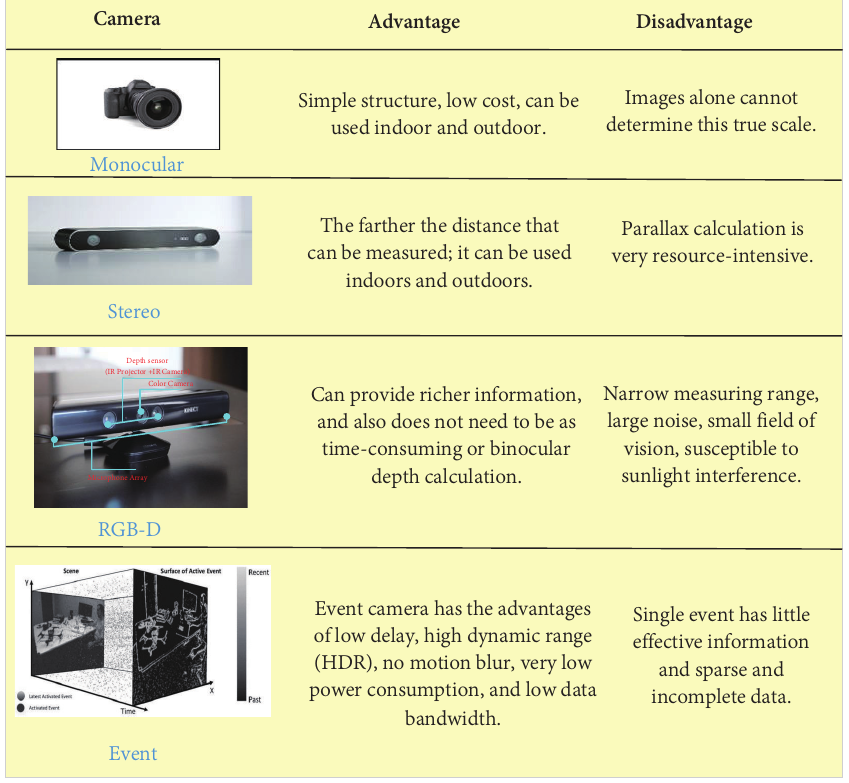
Figure 3. Comparison between different cameras. An event camera is not a specific type of camera, but a camera that can obtain “event information”. “Traditional cameras” work at a constant frequency and have natural drawbacks, such as lag, blurring, and overexposure when shooting high-speed objects. However, the event camera, a neuro-based method of processing information similar to the human eye, has none of these